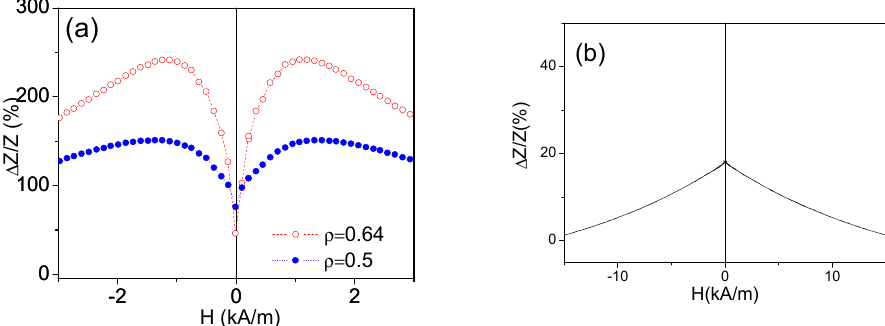
Figure 3. Δ Z/Z ( H ) dependencies of as-prepared Co 67 Fe 3.85 Ni 1.45 B 11.5 Si 14.5 Mo 1.7 with different ρ –ratios ( a ) and for as-prepared Fe 75 B 9 Si 12 C 4 microwires; ( b ) measured at 500 MHz.